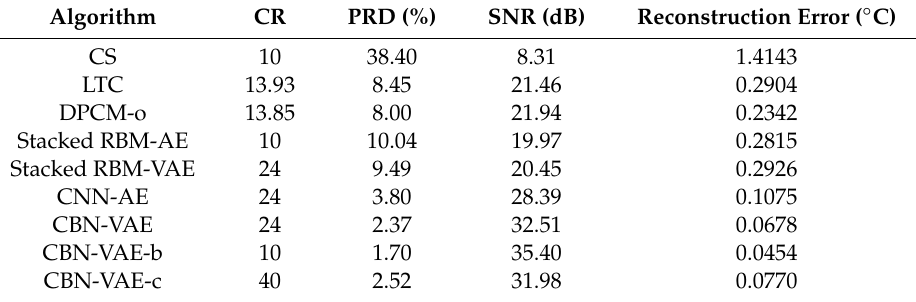
Figure 6. The reconstructed data and the original data of Node 7. Table 2. Compression performance comparison.